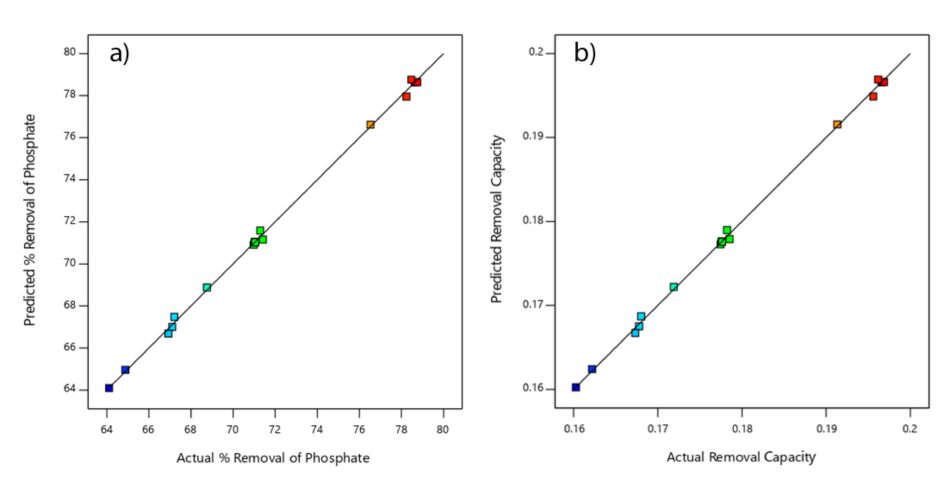
Figure 5. The plot of predicted versus measured values for: ( a ) % removal and ( b ) removal capacity, q. Figure 6 elucidates the surface response of the combined e ff ect of the tested experimental conditions on phosphate removal. It can be seen from Figure 6a that the percent removal of phosphate increases with increasing contact time from 120 min to 240 min at a minimum initial concentration of 5 mg / L. Similarly, Figure 6b,c shows the impact of initial concentration with solution pH and contact time with solution pH respectively. From Figure 6c, however, the impact of the combined e ff ect of contact time and solution pH was not significant on the removal of the phosphate as compared to the impact of contact time and initial concentration.